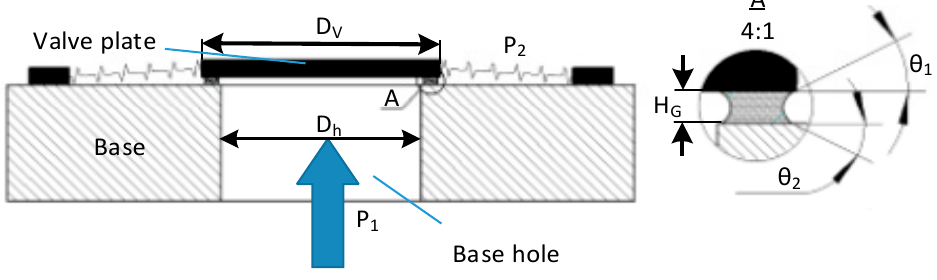
Figure 6. Opening and force for the inlet valve.